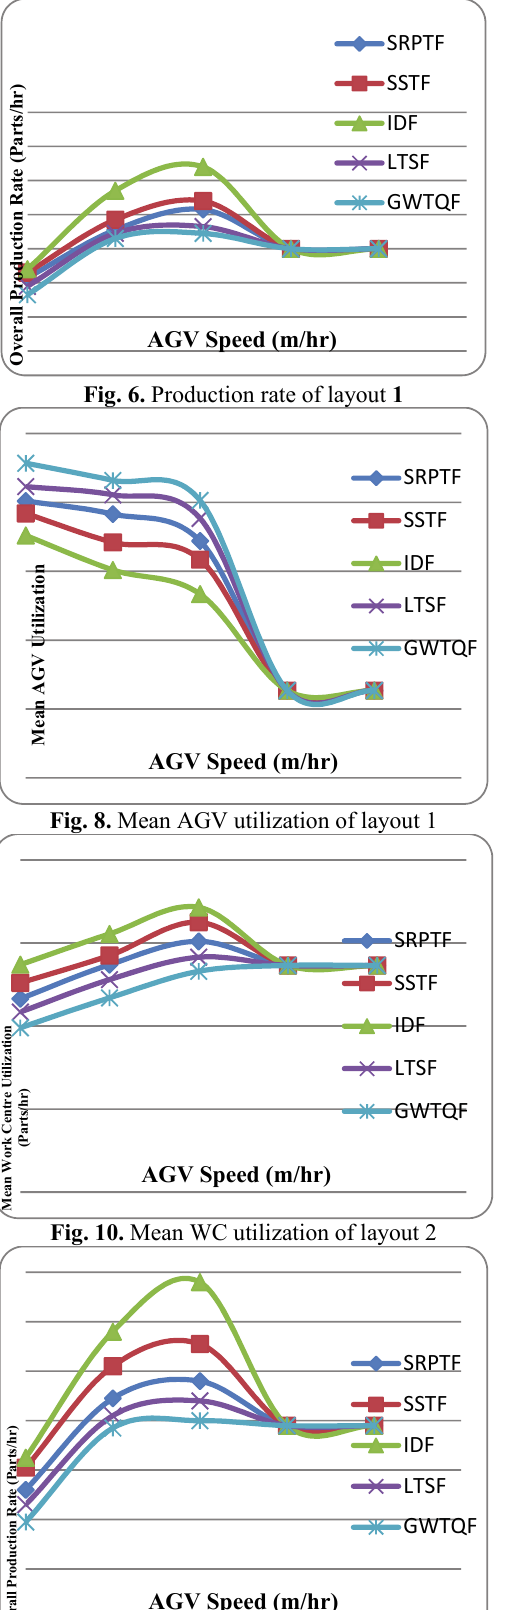
Fig. 10. Mean WC utilization of layout 2 Fig. 11. Mean AGV utilization of layout 2